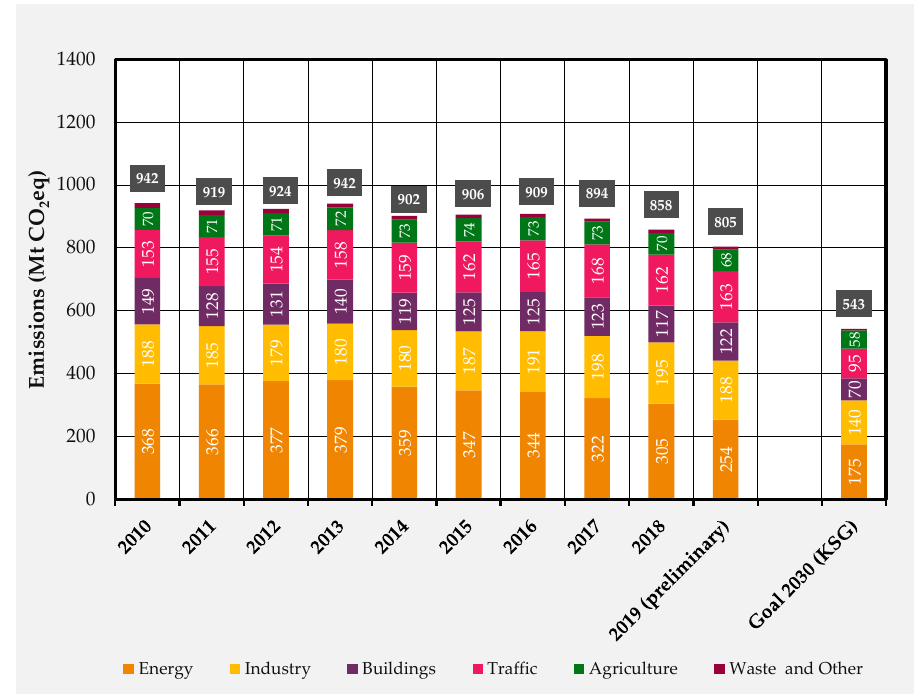
Figure 1. Development of greenhouse gas (GHG) emissions in Germany in sectors defined by Climate Change Act. Data are obtained from numbers published by the German Environment Agency [2].